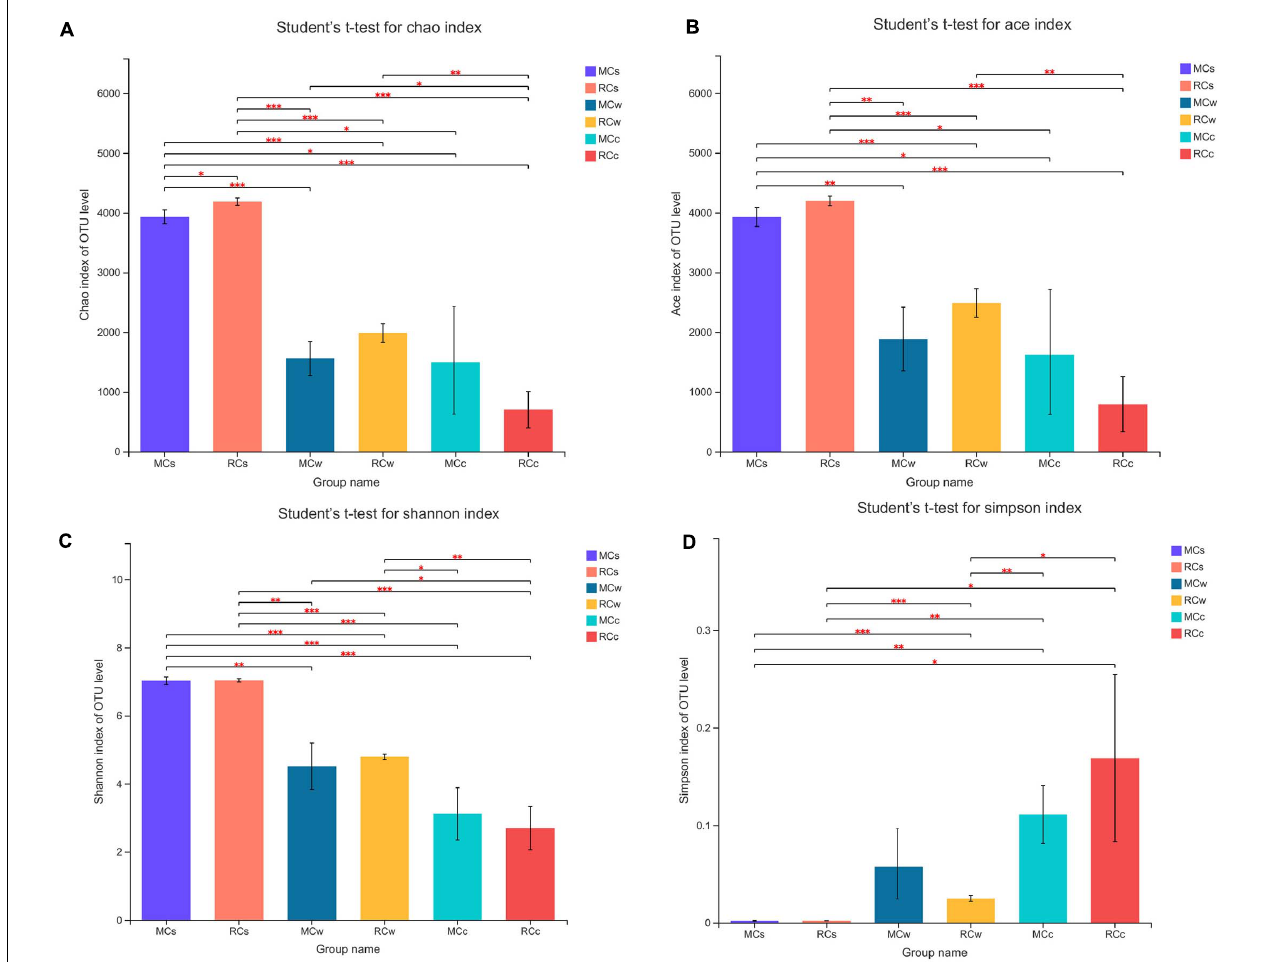
FIGURE 1 | Differences in richness and diversity of bacterial species between sampling groups. (A) Chao1 index of OTU level. (B) Ace index of OTU level. (C) Shannon index of OTU level. (D) Simpson index of OTU level. Differences were assessed with Student’s t -test: * 0.01 < P ≤ 0.05; ** 0.001 < P ≤ 0.01; *** P ≤